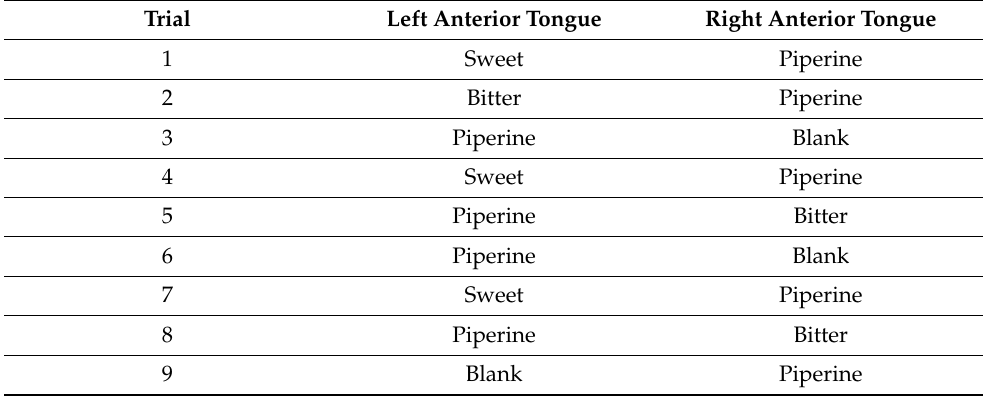
Table 2. The test protocol used for the strips’ presentation in Experiment